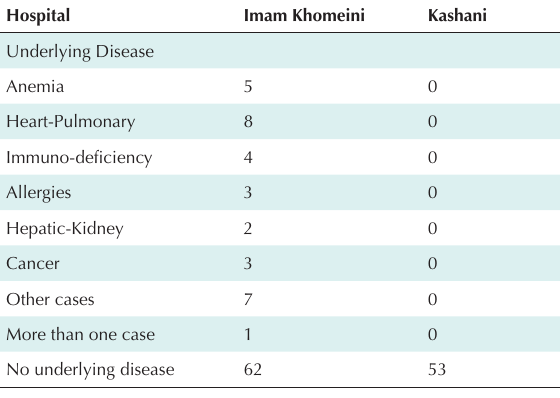
Table 3. Frequency of Complications After Transfusion Based on the Underlying